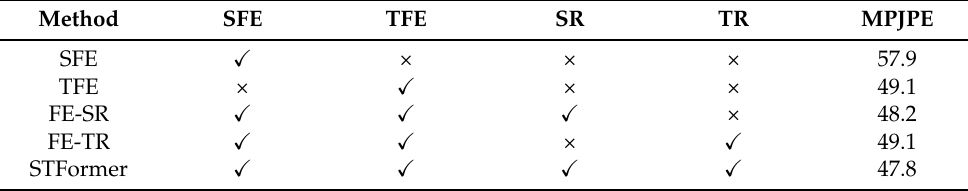
Table 5. Validation of the effectiveness of the different